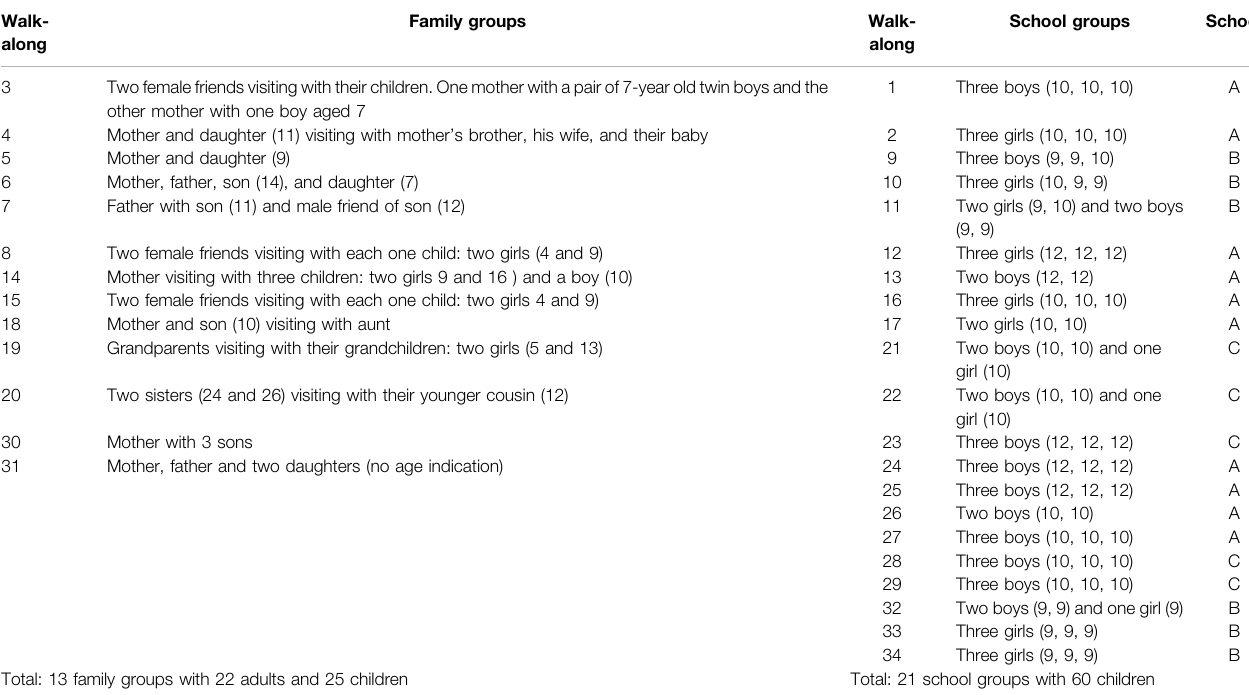
TABLE 2 | Overview of composition of visitor groups. Walk- along